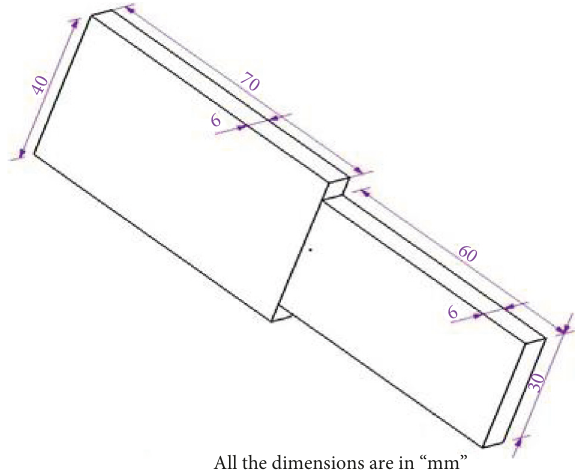
Figure 3: Dimensions of the LFW-Ti6Al4V alloy joint configuration.